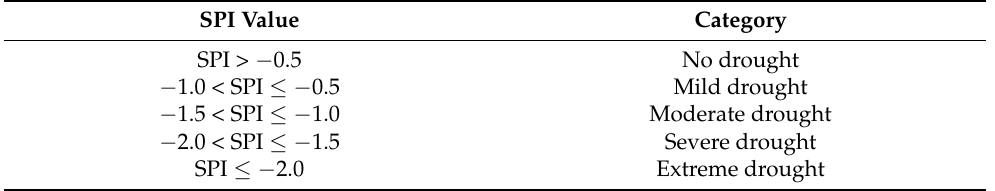
Table 2. Drought classification based on